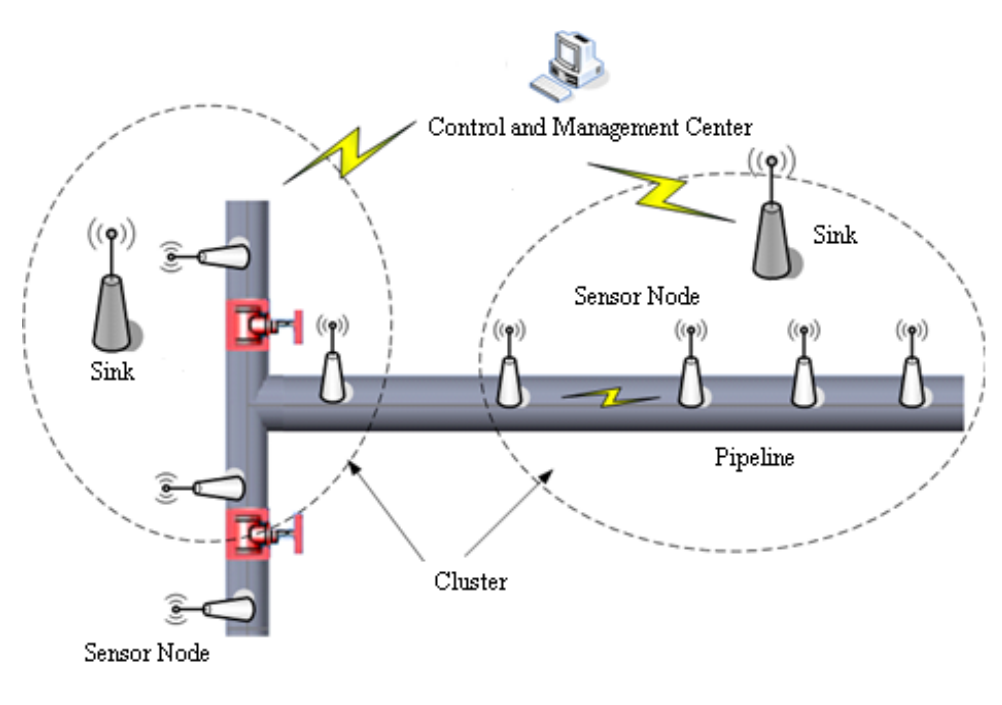
Figure 1. Architecture of pipeline monitoring sensor